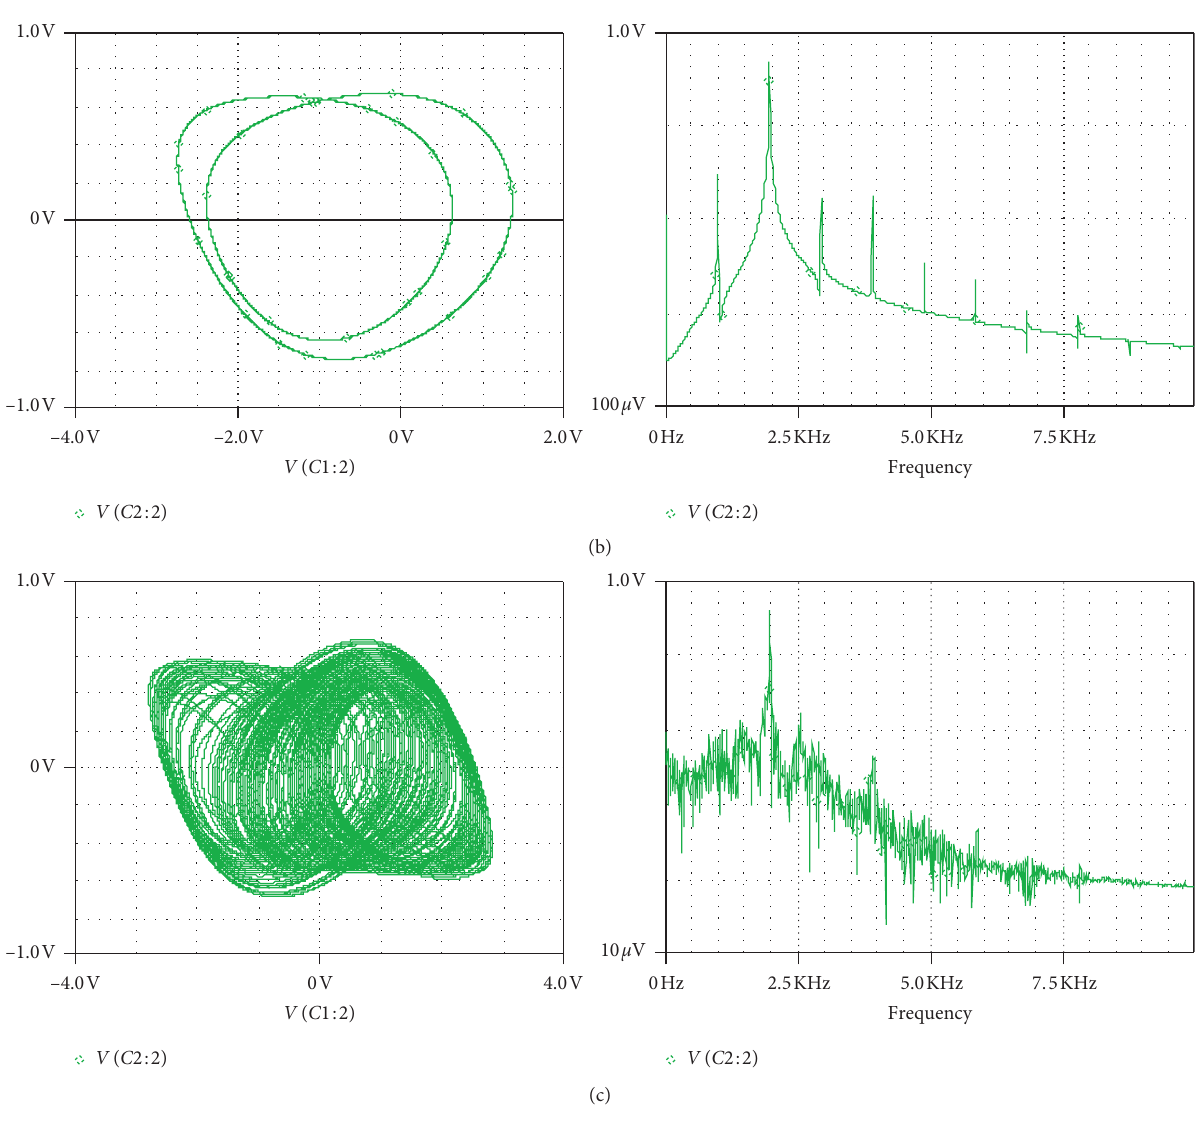
Figure 12: Phase portraits showing the unique surviving asymmetric and symmetric attractors for different values of the equilibrium points of the uncontrolled oscillator using PSpice simulation: (a) for V � 180 K Ω , with initial conditions ( 4 . 3V0 V , 0 V , 0V ) R δ